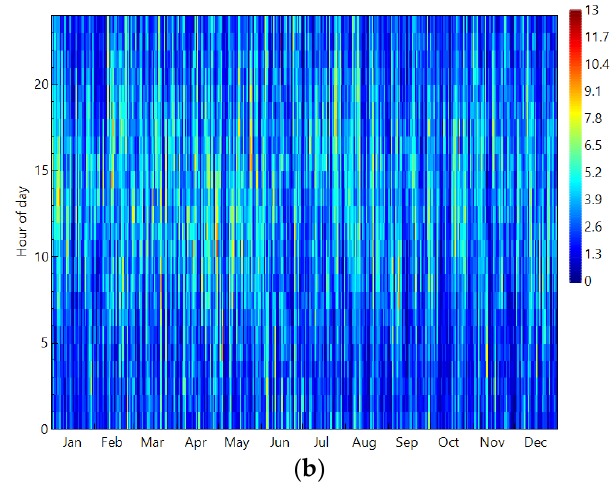
Figure 3. Heat map of annual: ( a ) solar GHI; ( b ) wind speed.